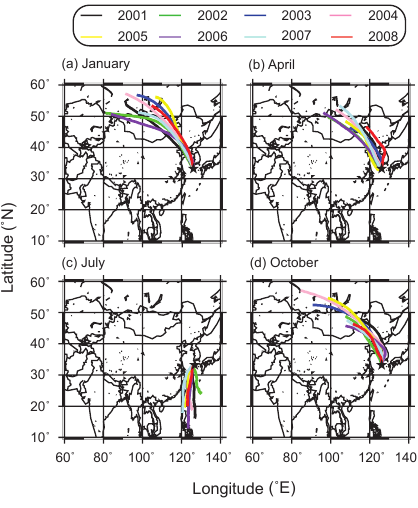
Figure 1. Map showing the Gosan site (star symbol) on Cheju Is- land, South Korea, along with the monthly averaged air mass back- ward trajectories for the time period of 2001–2008: (a) January, (b) April, (c) July and (d) October. Backward trajectories were cal- culated using the NOAA HYSPLIT model at 500m above ground level over 5